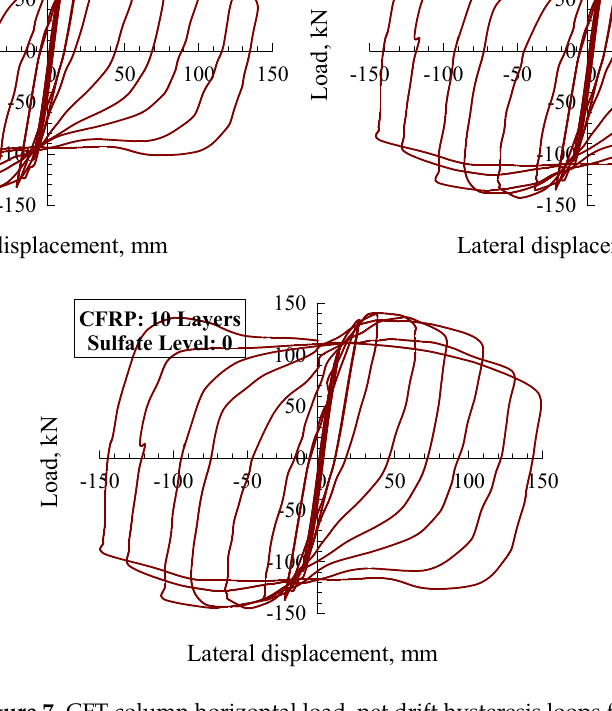
Figure 7. CFT column horizontal load–net drift hysteresis loops for sulfate level 0.